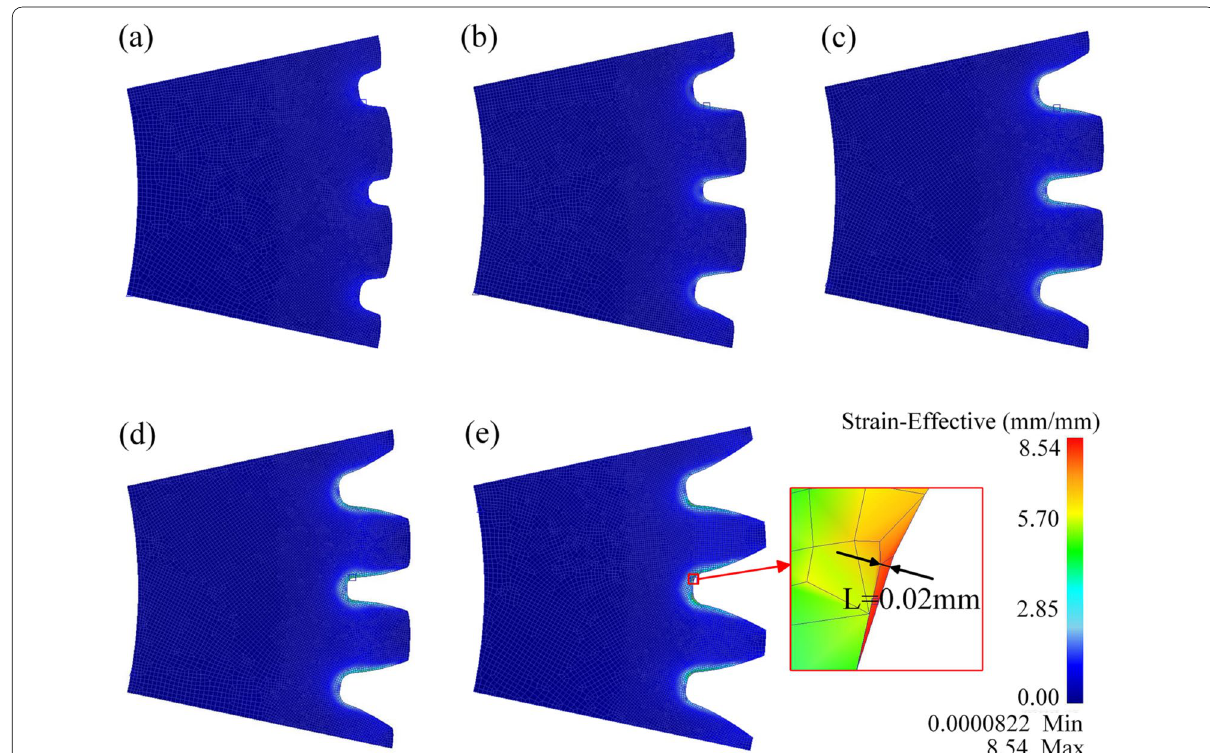
Figure 8 Teeth shapes and equivalent strain distributions of every pass in Scheme 3-2: (a) pass 1, (b) pass 2, (c) pass 3, (d) pass 4 and (e) finishing